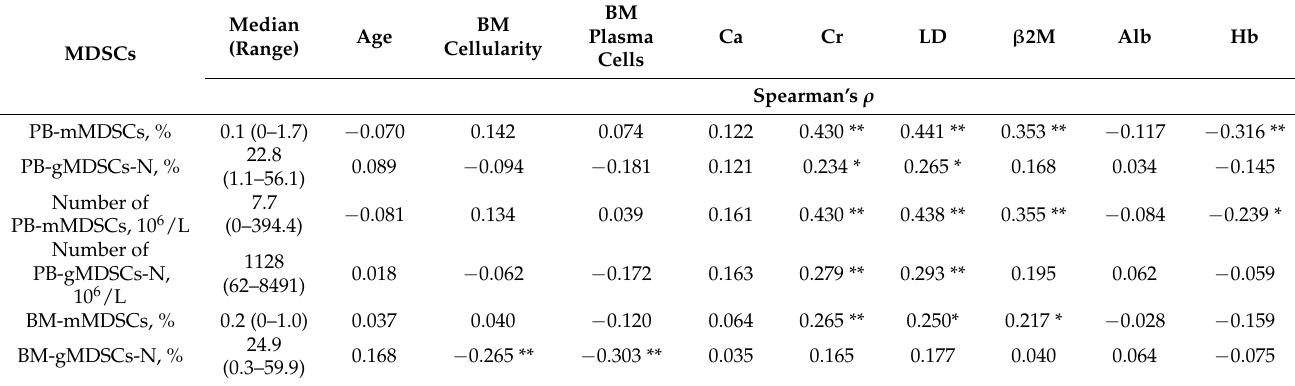
Table 2. Median and range of measured values of myeloid-derived suppressor cells and correlation with prognostic markers in 97 newly diagnosed patients with plasma cell